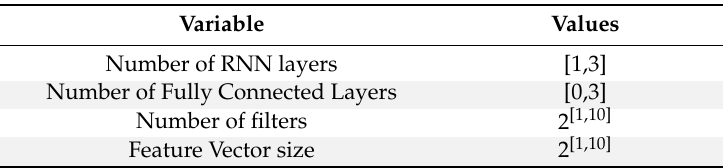
Table 2. Hyperparameter random